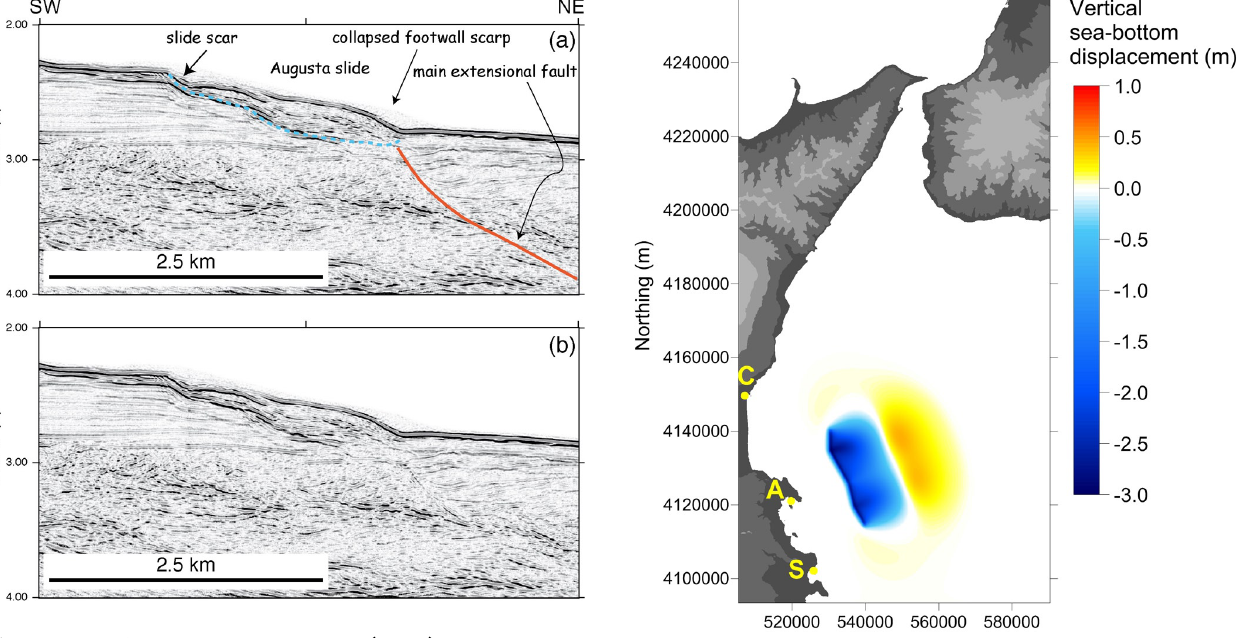
Fig. 4. Detail of seismic profile MESC 08 (Fig. 3). The interpreted seismic line (a) shows the collapsed sediments in the footwall scarp of the active splay of the major normal fault. The body of the slide has a volume of ca. 5km 3 and has slid about 200 m. Vertical exag- geration ca. 1.7. (b) Non-interpreted seismic line.